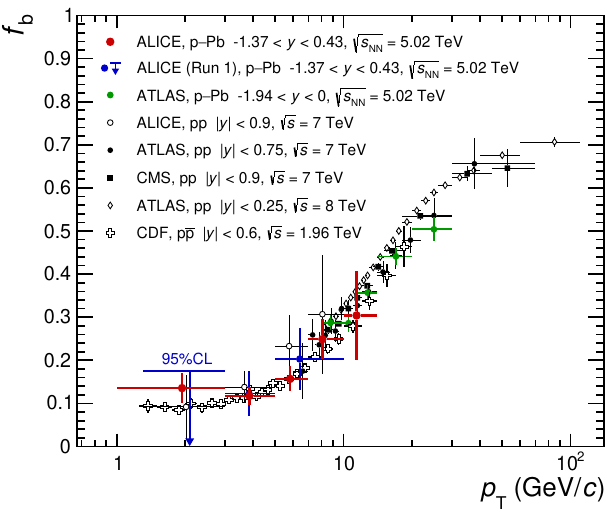
Figure 4 . Fraction of J /ψ from b-hadron decays at midrapidity as a function of the J /ψ p in T √ p-Pb collisions at s = 5 . 02 TeV (red closed circles) compared with results from the ALICE [51] NN and ATLAS [60] collaborations in the same collision system (blue and green closed circles, and the blue arrow that shows an upper limit at 95% CL in the range 1 . 3 < p < 3 GeV/ c ). The results T √ from CDF [3] in p p collisions at s = 1 . 96 TeV and those of the ALICE [13], ATLAS [96, 98], √ √ and CMS [97] collaborations in pp collisions at s = 7 TeV or s = 8 TeV are also shown (black symbols). For all experiments, vertical error bars represent the quadratic sum of the statistical and systematic uncertainties. The data points of ALICE are placed horizontally at the mean value of the p distribution within each p -interval, determined from the MC simulations described in the T T